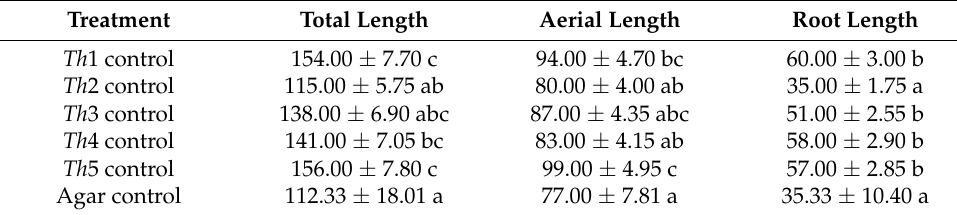
Table 8. Growth promotion effects of Trichoderma strains. Total, aerial, and root biomass lengths in cm (mean ± standard deviation) of grafted plant controls treated with T. harzianum and untreated (agar only). Data are referred to the experiment of protection against N. parvum .